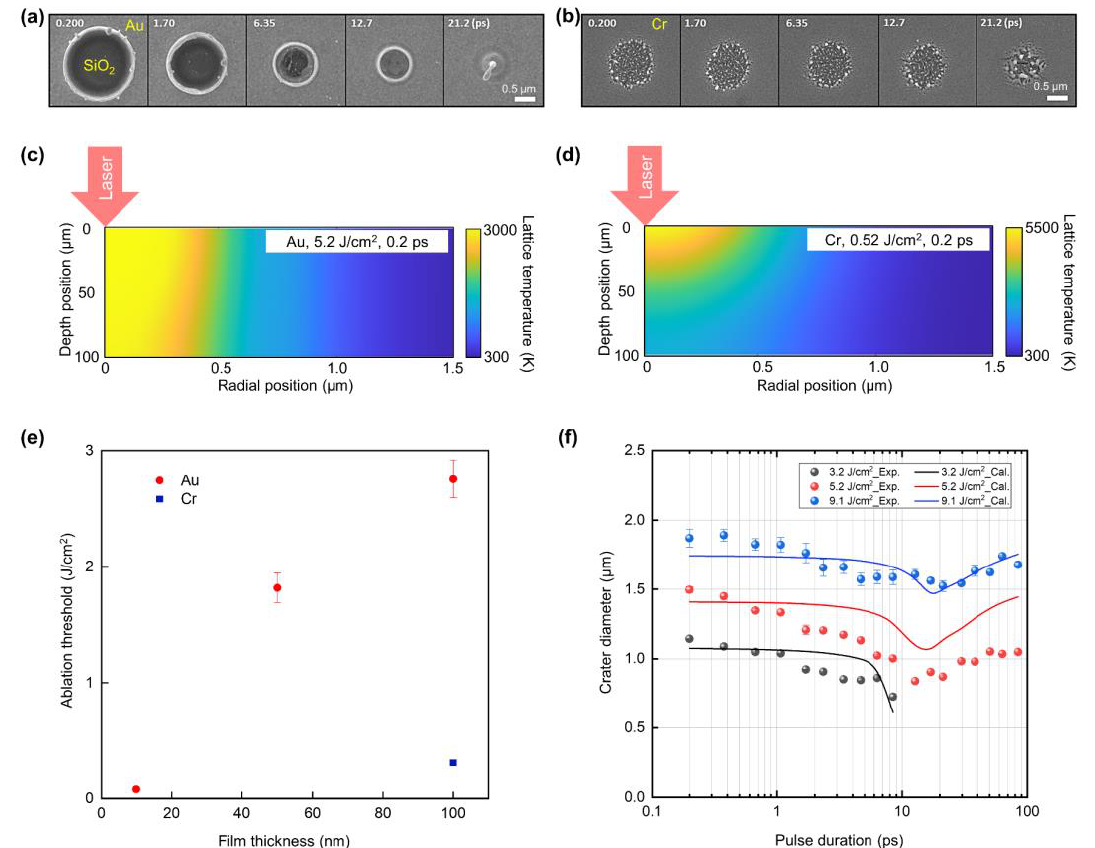
Figure 3. Single-pulse ablation on 100 nm-thick Au and Cr films. SEM images of the craters made on ( a ) Au and ( b ) Cr thin films with laser fluence of 5.2 and 0.52 J/cm 2 , respectively. Pulse durations are indicated in the SEM images. Calculated 2D temperature distribution inside ( c ) Au and ( d ) Cr thin films. ( e ) Ablation threshold of Au and Cr films as a function of thickness. ( f ) Crater diameter as a function of pulse duration.